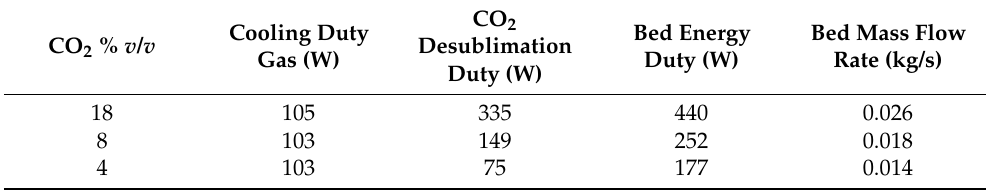
Table 3. Simulated moving bed energy duties and bed flow rates for various CO 2 concentrations using Equation (12).